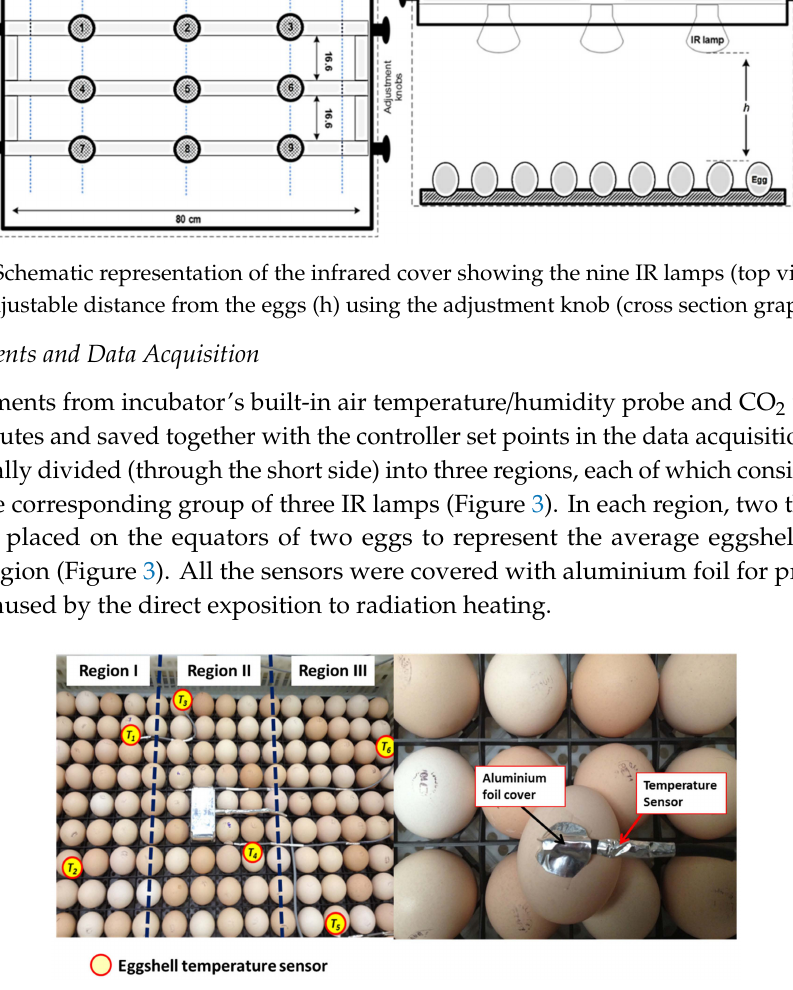
Figure 3. The location of the eggshell temperature sensors within each region (I, II and III) in the experimental incubator (left picture) and the temperature sensor placed on the equator of the eggshell covered with an aluminium foil to be protected from the IR heating (right